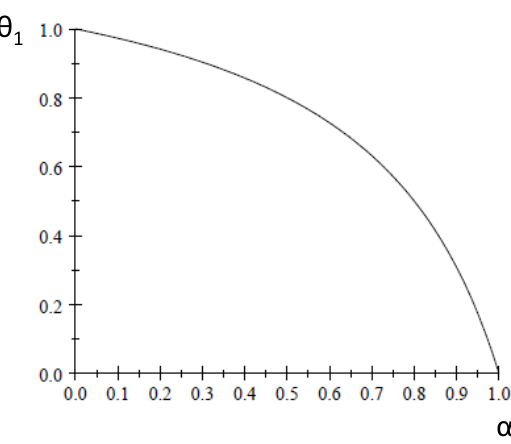
Figure 1. Parameter regions (mixed-strategy equilibrium below